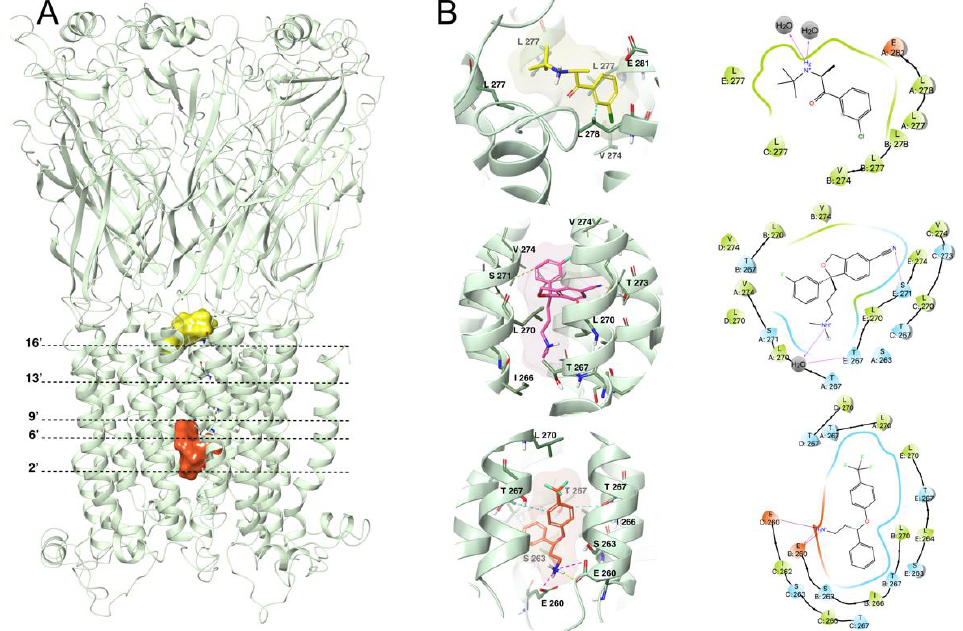
Figure 6. ( A ) Representation of the general location of antidepressants in the ion channel. The position of the representative rings is indicated by dotted lines. ( B ) Images corresponding to the last conformation of bupropion (yellow), escitalopram (pink), and norfluoxetine (orange) in the ion channel of the rat α 7 nAChR homology model binding pocket after a 100 ns Molecular Dynamics simulation. Hydrophobic interactions, H-bonds, and ionic interactions are shown in cyan, yellow, and fuchsia, respectively.